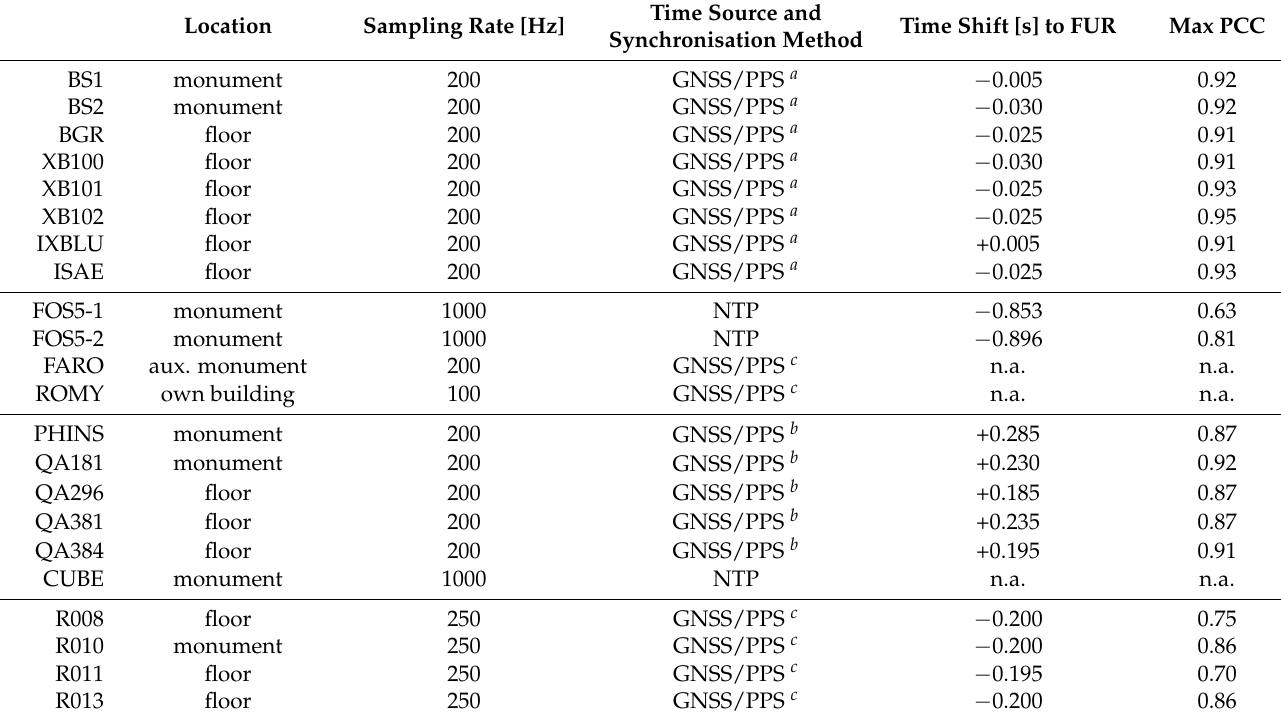
Table 1. Locations within the seismic bunker, sampling rates, absolute time source and synchronisation method, time shift, and maximum Pearson cross-correlation coefficient (PCC) between station FUR (vertical component) and the evaluated sensors (transverse component). The Global Navigation Satellite System (GNSS) with pulse per second (PPS) output and Network Time Protocol (NTP) were used to retrieve absolute time stamps. The signal-to-noise ratio of the CUBE recording was too low for a reasonable cross-correlation. FARO and ROMY were installed in separate buildings and, therefore, they were not considered to be co-located with the other sensors (n.a. = not